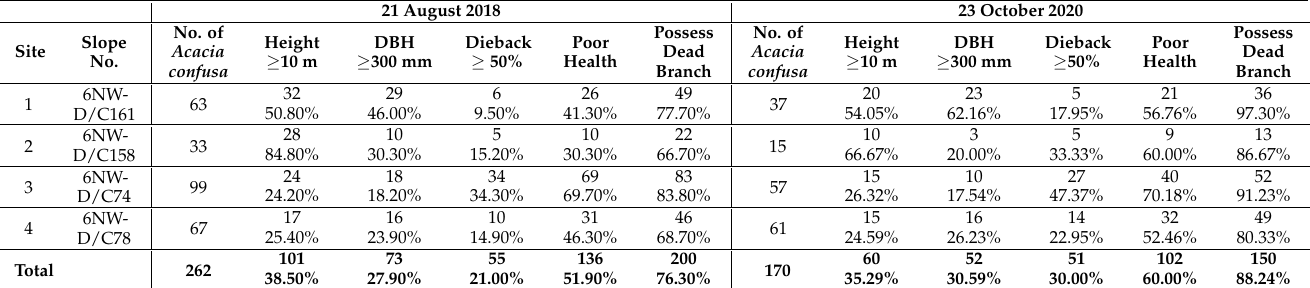
Table 5. Characteristics of A. confusa in the study sites in Aug 2018 and Oct